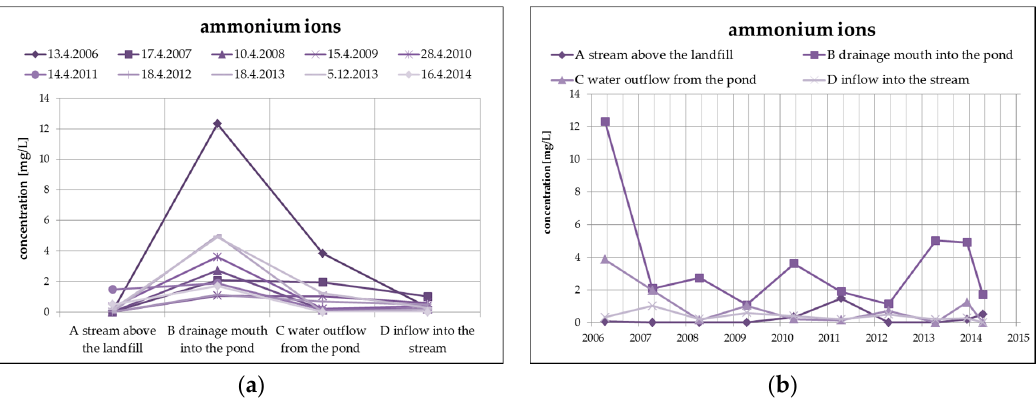
Figure 7. Change of values of ammonium ions in surface water depending on the monitored profile ( a ) and time ( b ).